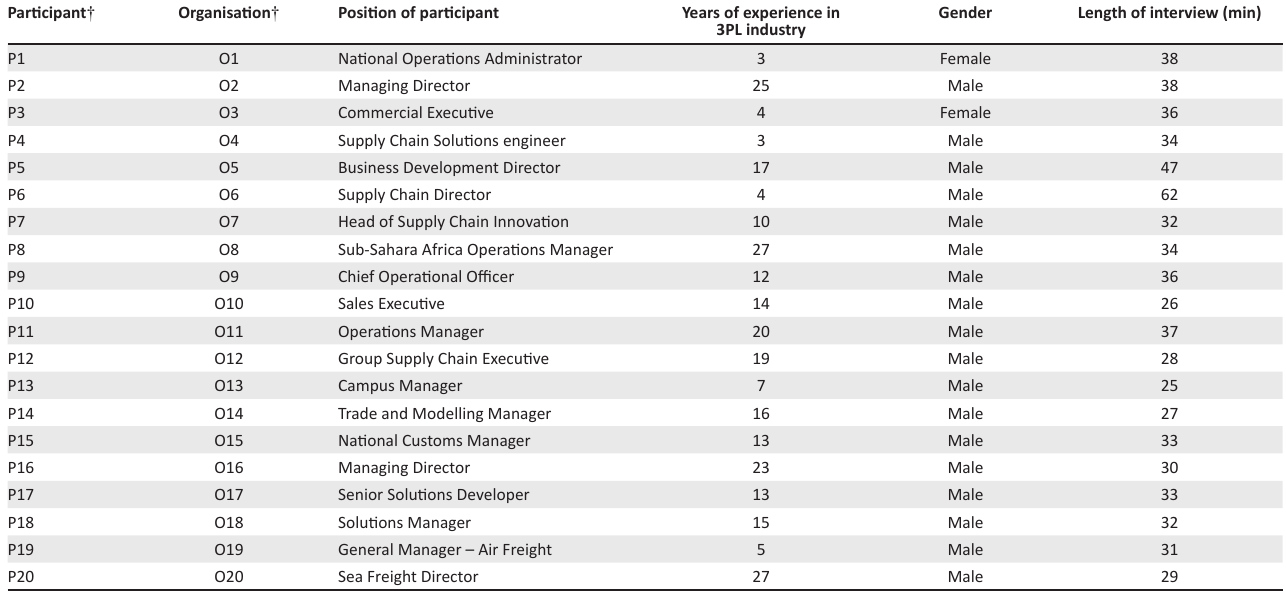
TABLE 1: Participants and organisations